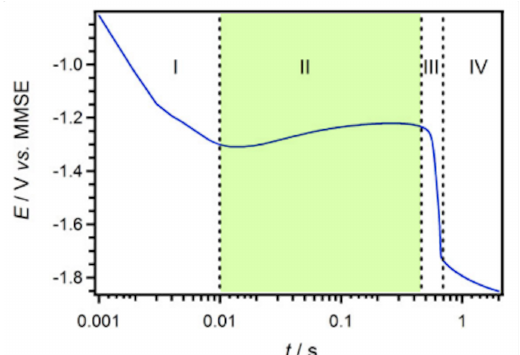
Figure 5. Polarization curve for the galvanostatic deposition of nickel on a gold electrode. (I) The potential drops as the electrode’s capacitance is charged, reaching values more negative than the onset for hydrogen evolution reaction (HER) on gold, i.e., − 0.70V vs. MMSE (II) then a slow recovery of ca. 100mV is observed, followed by (III) a significant drop towards (IV) a gradual polarization towards more negative potentials. Retrieved from